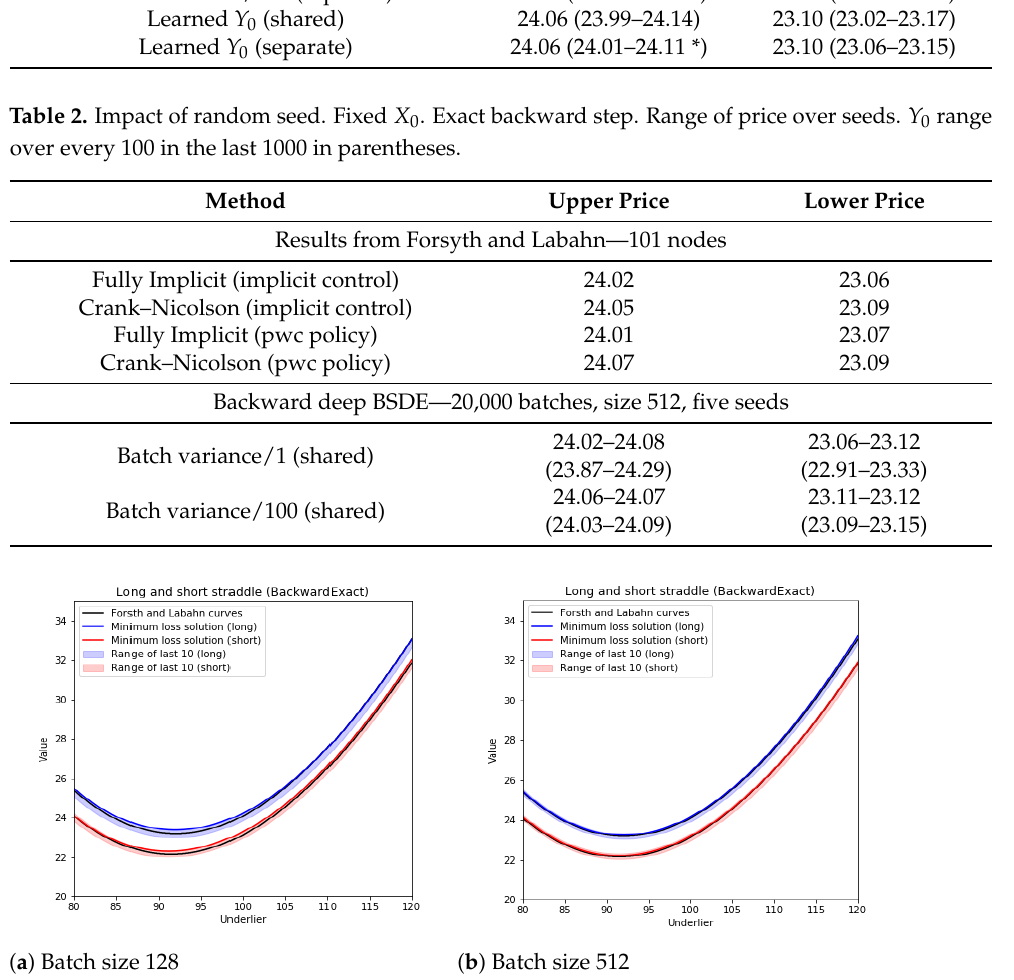
Figure 10. Yinit ( X 0 ) for two batch sizes and backward exact step plotted against Forsyth and Labahn curves from (Forsyth and Labahn 2007, Figure